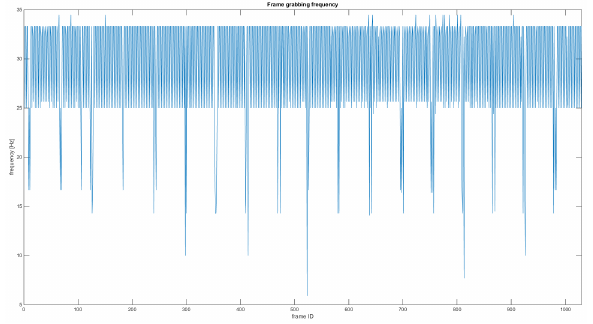
Figure 1. Frequency diagram of the Kinect sensor